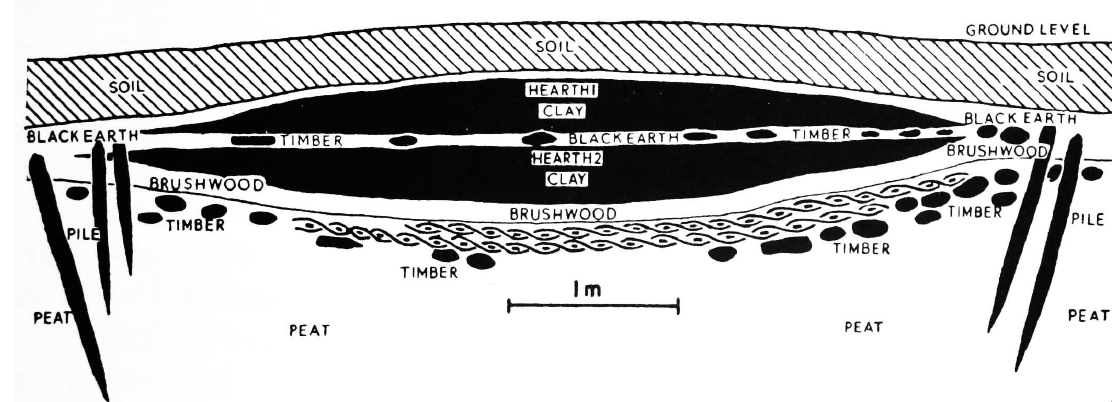
Figure 5 Section through a mound (LVI) at Glastonbury Lake Village, England, showing the layer of wattle hurdles of a trackway towards the bottom (Source: Bradford 1954, 319, after A. Bulleid and H. St. G. Gray. 1911. The Glastonbury Lake Village. Glastonbury: Glastonbury Antiquarian Society, vol. 1, p. 134, figure